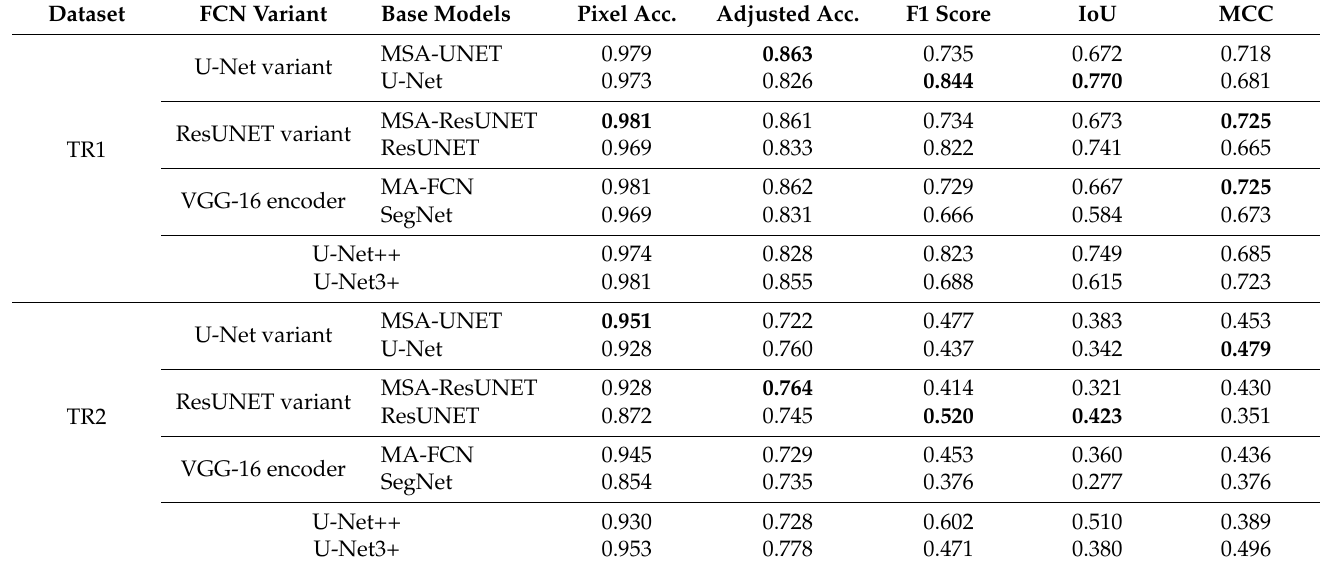
Table 2. Same-domain validation results of the base model (M1) of MSA-UNET on TR1 and TR2 compared to MA-FCN, U-Net, and SegNet. The highest values are highlighted in